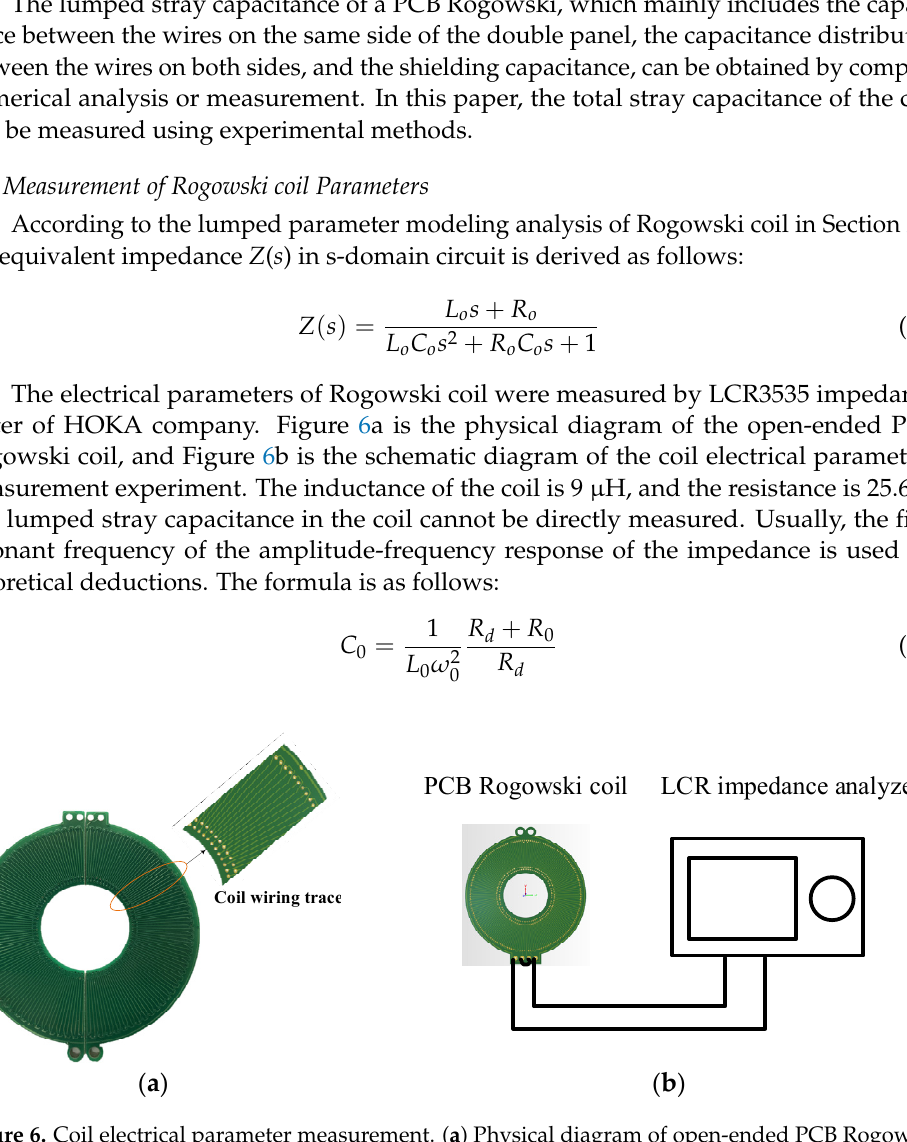
Figure 6. Coil electrical parameter measurement. ( a ) Physical diagram of open-ended PCB Rogowski coil; ( b ) Experimental diagram of coil electrical parameter